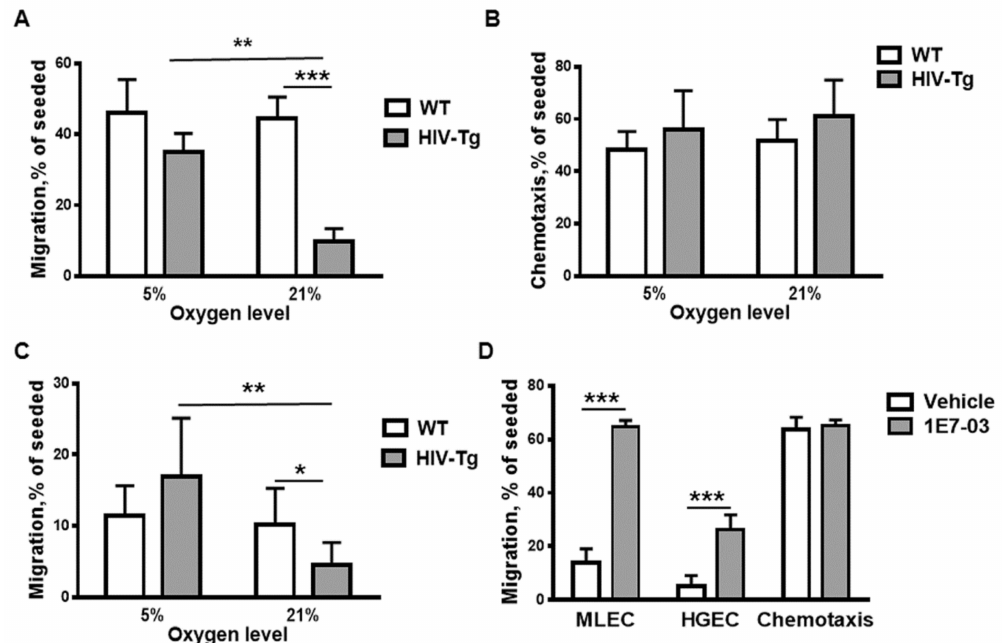
Figure 4. Trans-endothelial migration of HIV-Tg macrophages reduced at 21% oxygen in vitro. ( A ) Trans-endothelial migration of peritoneal macrophages isolated from WT and HIV-Tg mice through mouse lung endothelial cells at 5% and 21% oxygen. n = 4 ( B ) Chemotaxis of peritoneal macrophages at 5% and 21% of oxygen. n = 3 ( C ) Trans-endothelial migration of peritoneal macrophages isolated from WT and HIV-Tg mice through human renal endothelial cells at 5% and 21% oxygen. n = 6. ( D ) Treatment of peritoneal macrophages isolated from HIV-Tg mice with 1E7-03 HIV-1 transcriptional inhibitor (1 µ M) significantly increases trans-endothelial migration at 21% oxygen without a ff ecting chemotaxis. n = 3. Mean and SD are shown. * p < 0.05, ** p < 0.01, *** p <